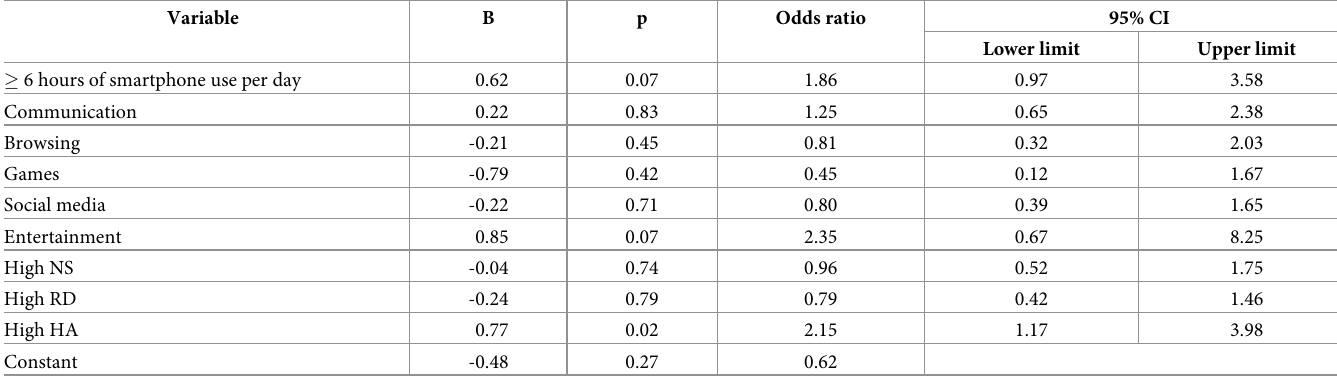
Table 5. Results of the univariate regression analysis.